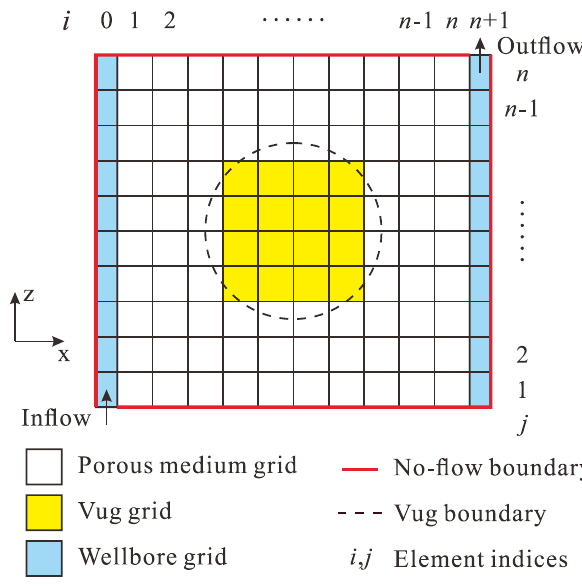
Figure 10. Discretization scheme of the single-vug model.